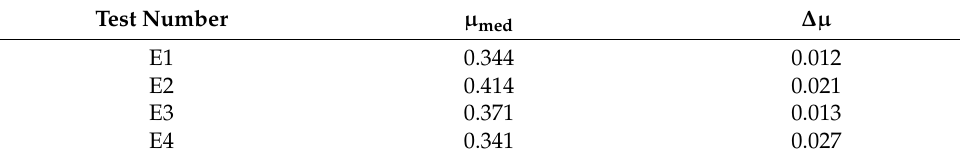
Table 5. Variation of the coefficient of friction for the system WC-Co/100Cr6.